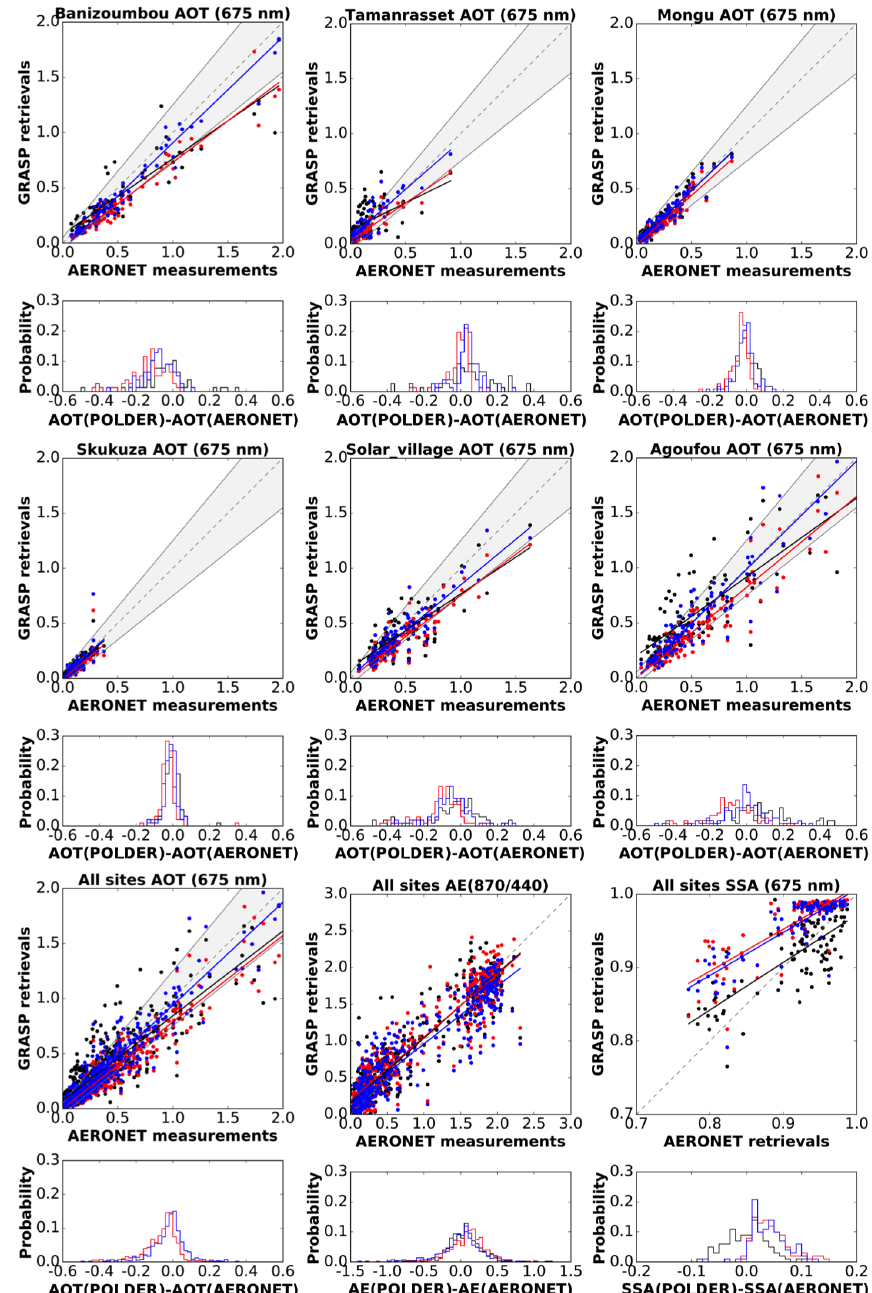
Figure 11. Intercomparison of the aerosol optical properties retrieved from POLDER/PARASOL and provided by the AERONET opera- tional product from six AERONET sites located in Africa and the Middle East during the period from 2006 to 2008. Red represents the Maxwell Garnett (MG) mixing model, blue represents the volume-weighted (VW) mixing model, and black represents the standard (ST) GRASP/PARASOL product that does not employ the aerosol component